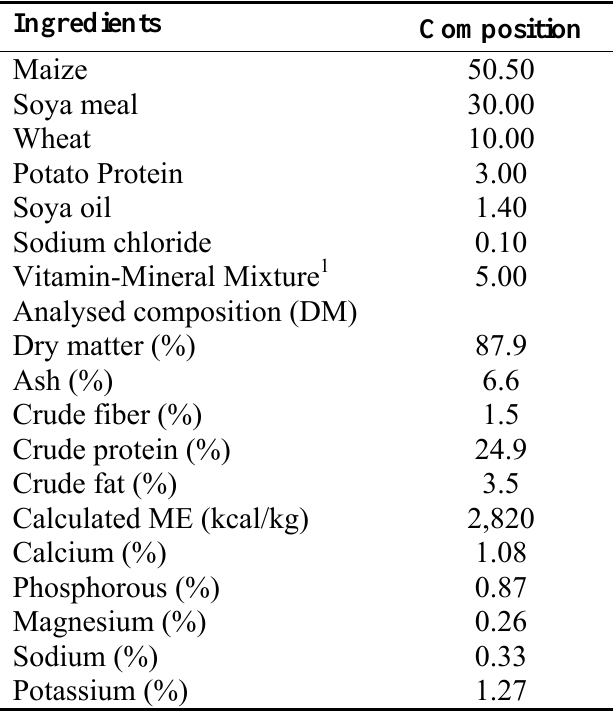
Table 1. Ingredient percentages and analysis of basal